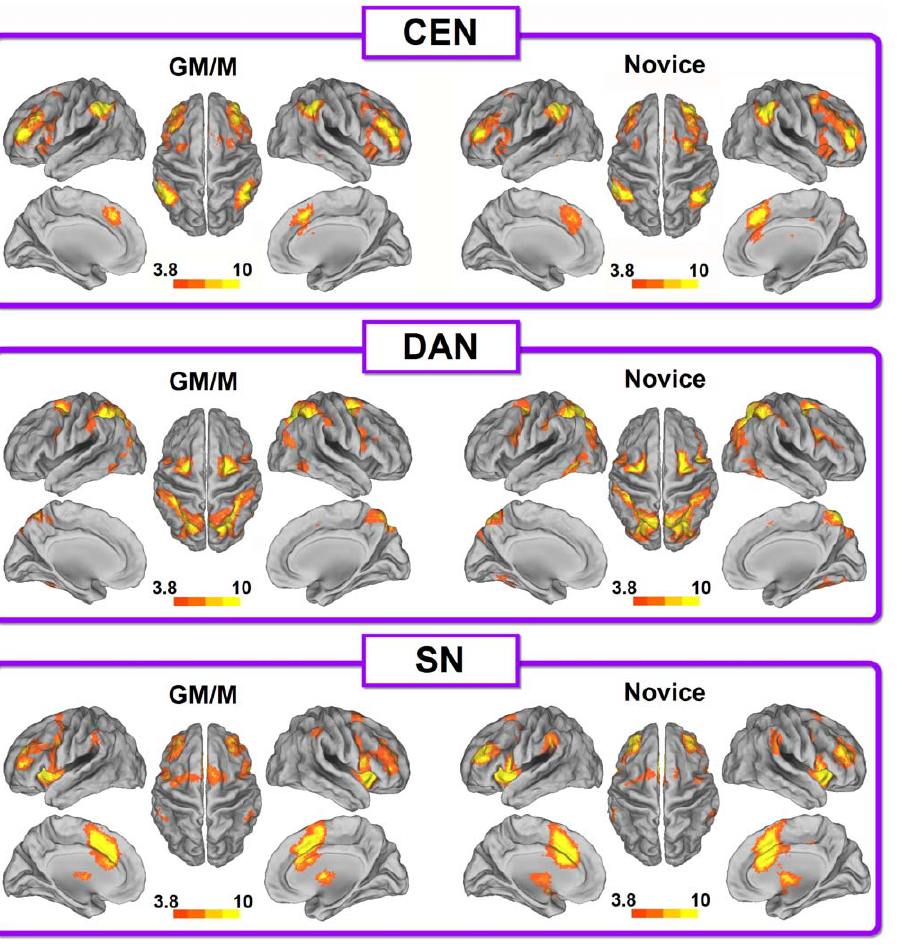
Figure 2. The population-averaged correlation maps of CEN, DAN and SN in GM/Ms and novices during resting-state experiment (One-sample t -test, p , 0.05, AlphaSim corrected). Seeds for resting-state functional connectivity calculation of these three networks were labeled by { in Table 1.